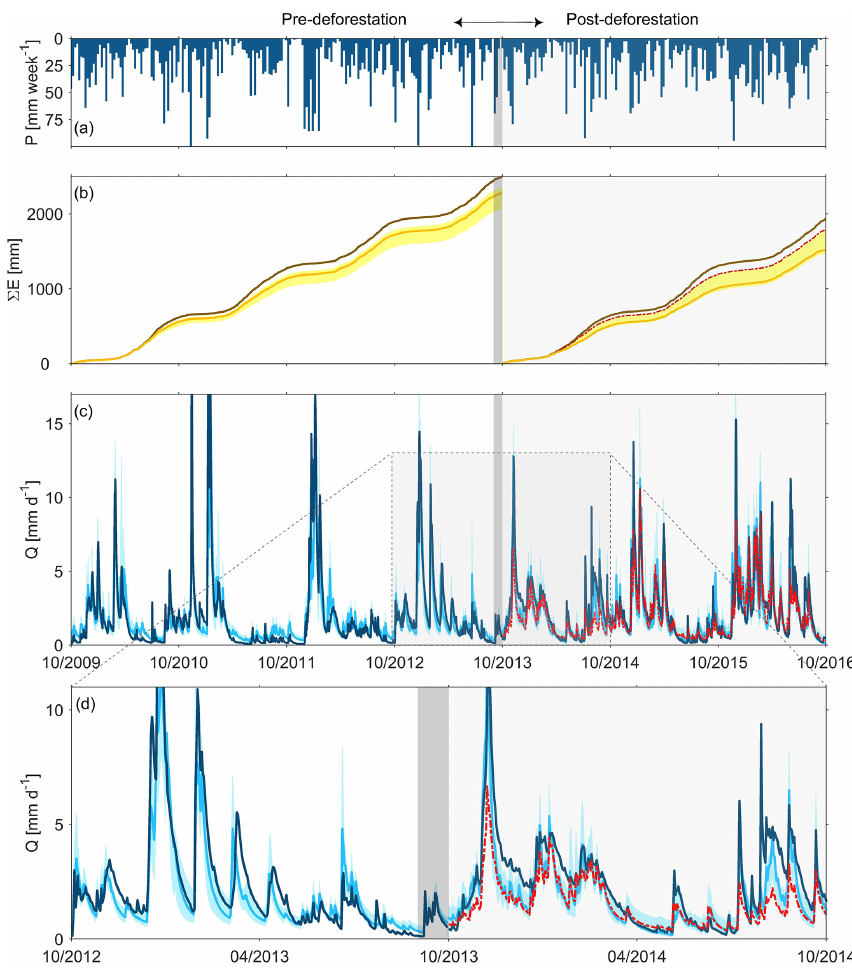
Figure 2. (a) Time series of observed weekly precipitation P ; (b) daily cumulative evaporative fluxes for the pre- and post-deforestation periods, where the dark brown line indicates potential evaporation E P and the orange lines and the yellow shaded areas show the actual evaporation E A modelled using the best fit parameter sets and the associated 5th / 95th percentiles of all feasible solutions of the pre- and post-deforestation periods, respectively. The dashed red line indicates the modelled E A in the post-deforestation period using the best fit pre-deforestation parameter set; (c) observed (dark blue line) and modelled daily streamflow Q ; light blue line indicates the best fit model and the shaded area the 5th / 95th percentile of all feasible solutions for the pre- and post-deforestation periods, respectively. The dashed red line indicates the modelled streamflow in the post-deforestation period using the best fit pre-deforestation parameter set; (d) zoom-in to the observed and modelled streamflow for the October 2012–October 2014 period. The grey shaded area indicates the deforestation